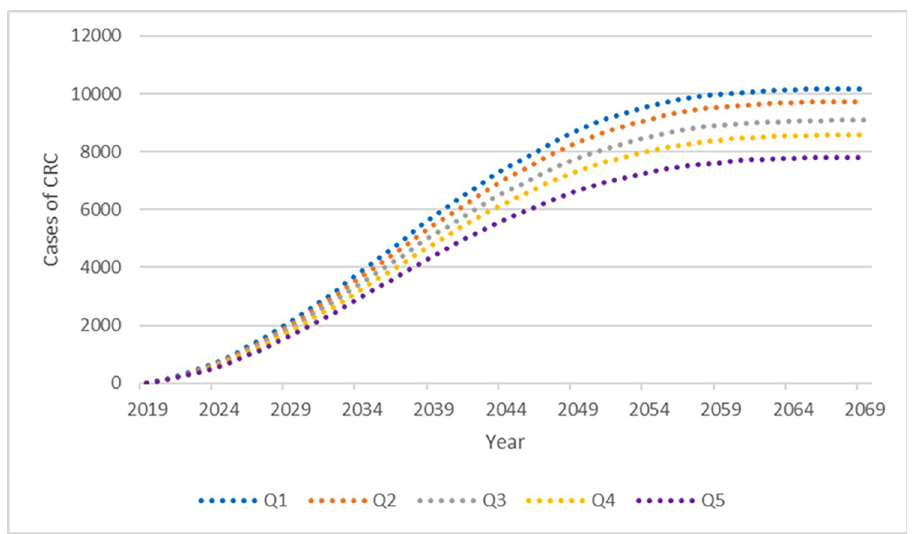
Fig 2. Predicted cases of CRC aged 50–74 years over the period 2019–2059 by SEIFA quintile.